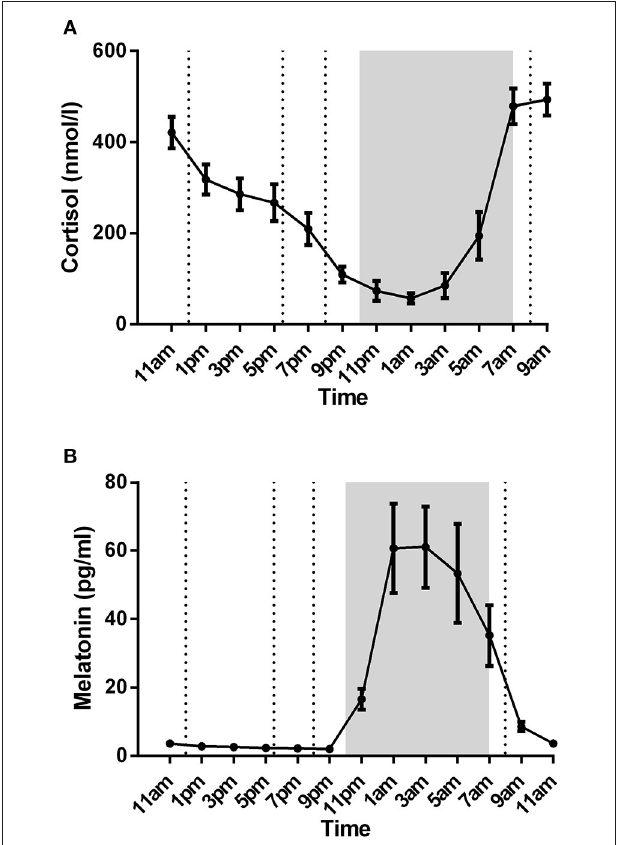
FIGURE 3 | Plasma cortisol (A) and melatonin (B) levels of nine healthy male subjects (mean ± SEM). Lunch, dinner, evening snack, and breakfast are marked with dotted lines in respective order. Night-time (lights off at 10 p.m; lights on at 7a.m) is marked with shaded region. Both cortisol and melatonin showed a normal circadian rhythm.